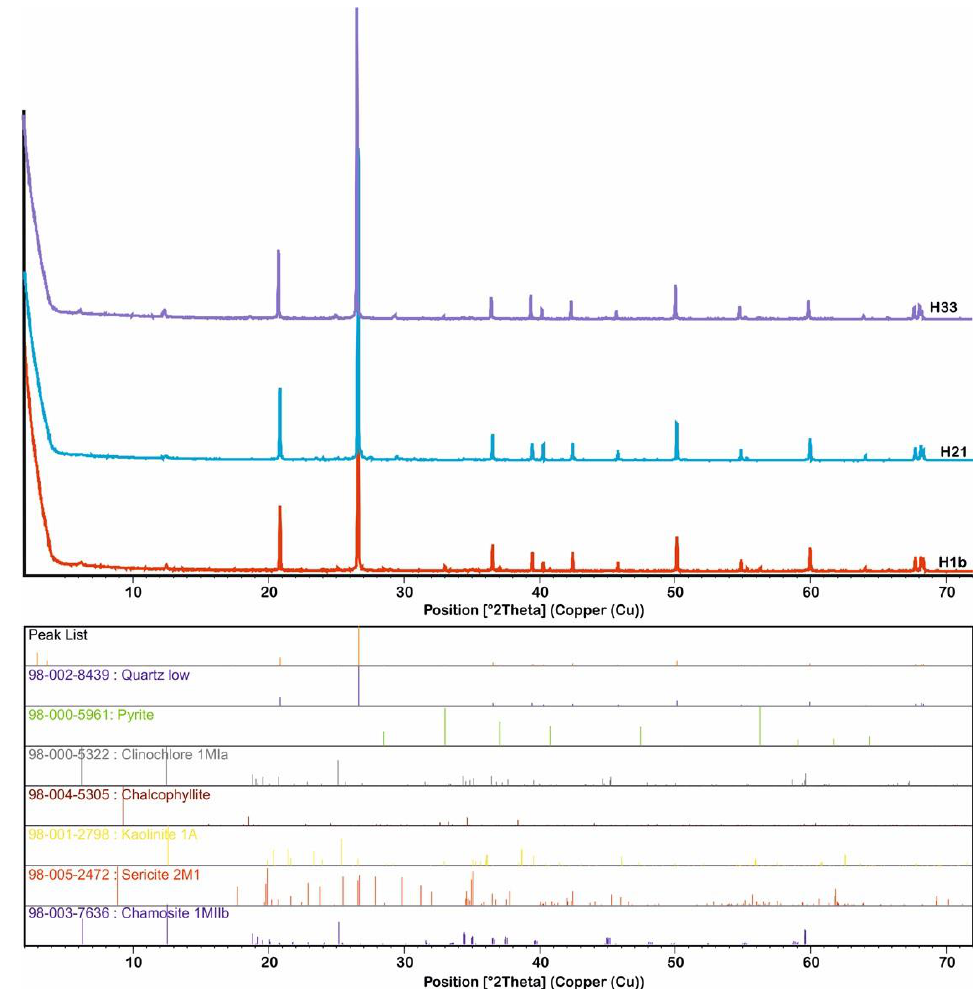
Figure 6. XRD patterns of representative samples from alteration zone-1 (sericite–quartz–chlorite ± kaolinite ± pyrite).